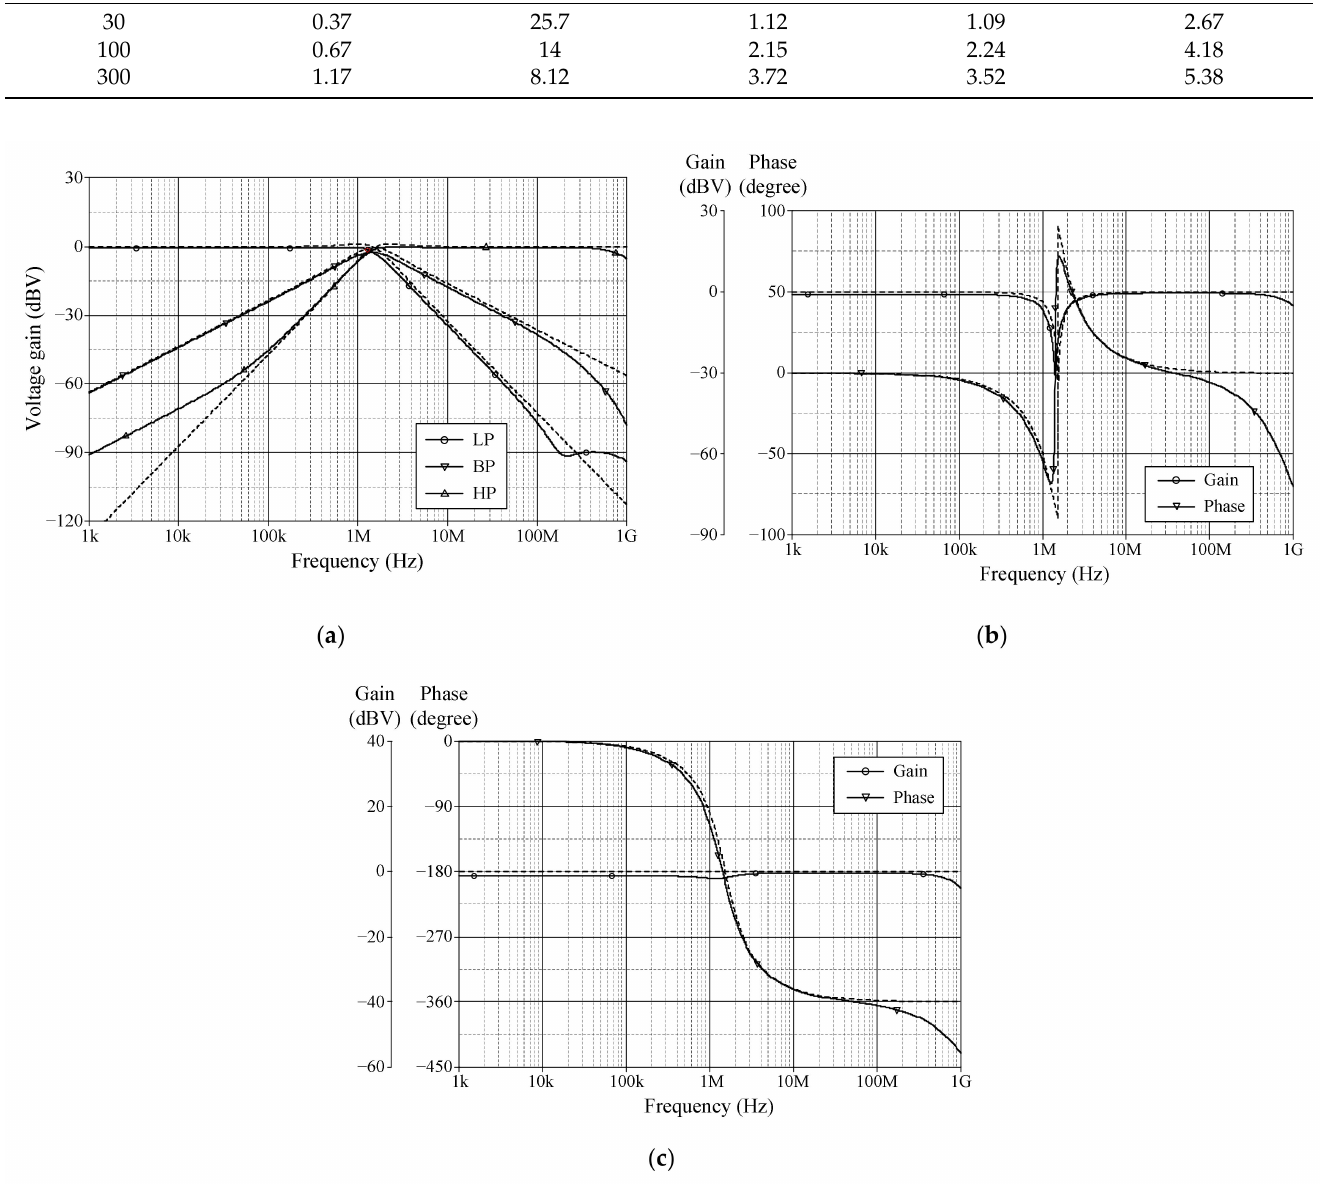
Figure 5. Ideal (dashed line) and simulated (solid line) frequency responses for VM: ( a ) LP, BP and HP; ( b ) BS; ( c )